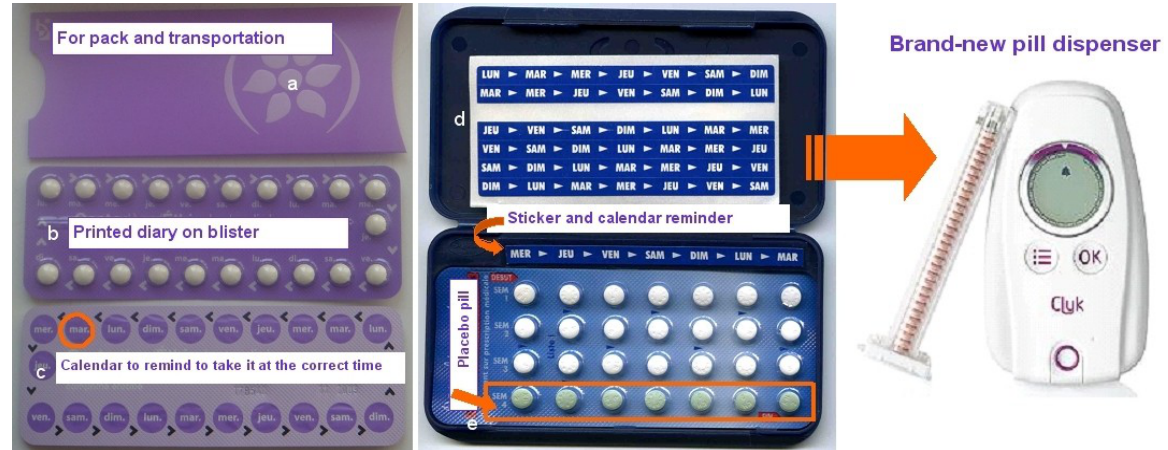
Figure 5. Examples of pills blisters [13].